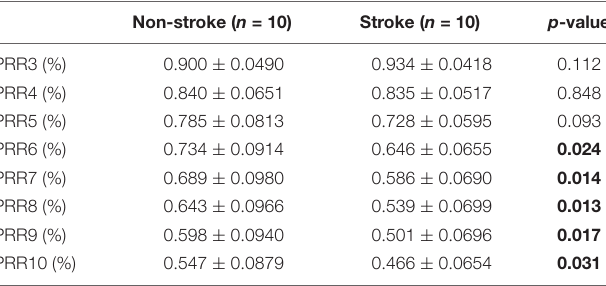
TABLE 4 | Particle residual ratio in